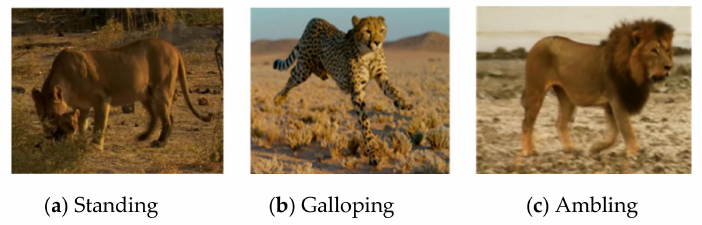
Figure 8. Example of the